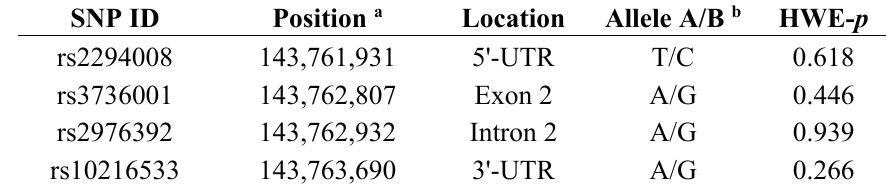
Table 1. Basic information of candidate single nucleotide polymorphisms (SNPs).